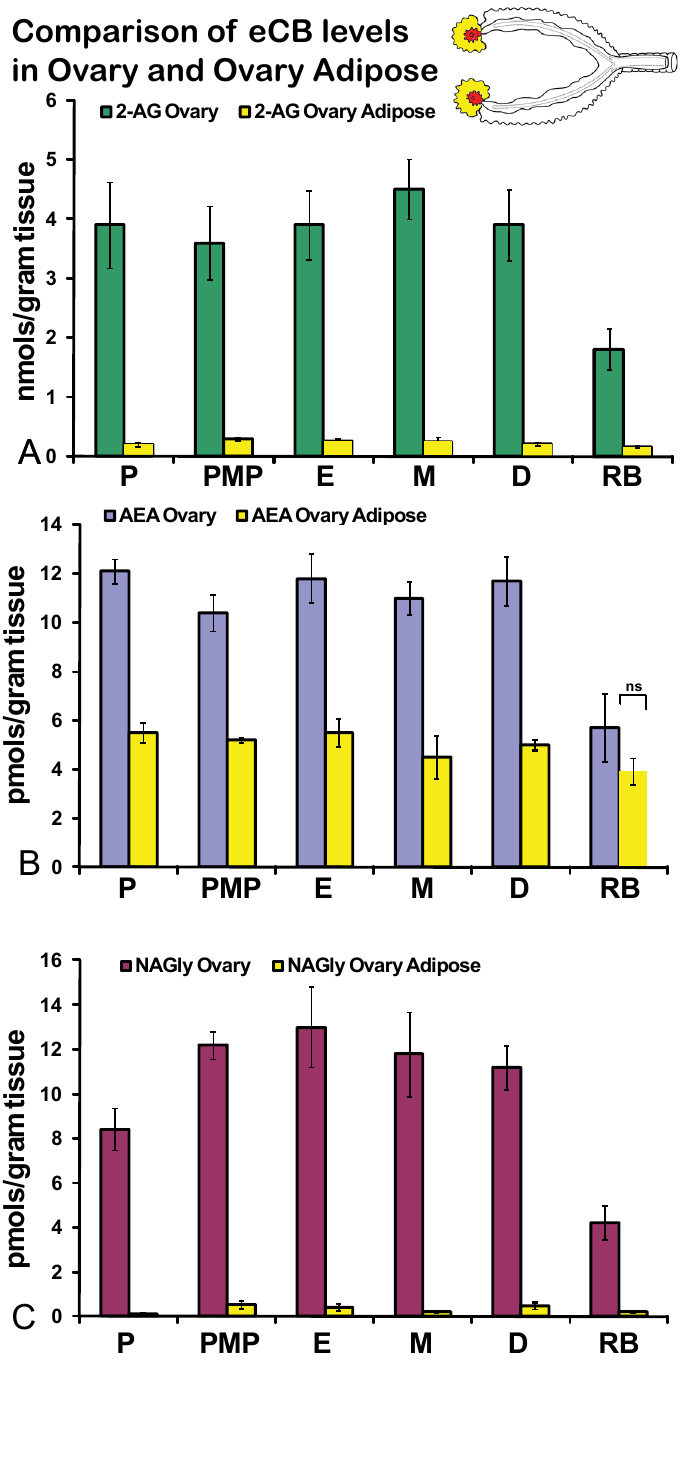
Figure 4. Comparisons of levels of eCBs in ovaries and ovarian adipose tissue. P = proestrus AM; PMP = proestrus PM; E = estrus; M = metestrus, D = diestrus; RB = anovulatory retired breeders. All experimental groups had significantly higher levels of eCBs in the ovary compared to the ovarian adipose tissue where p ≤ 0.05. The exception is labeled as NS for not significant